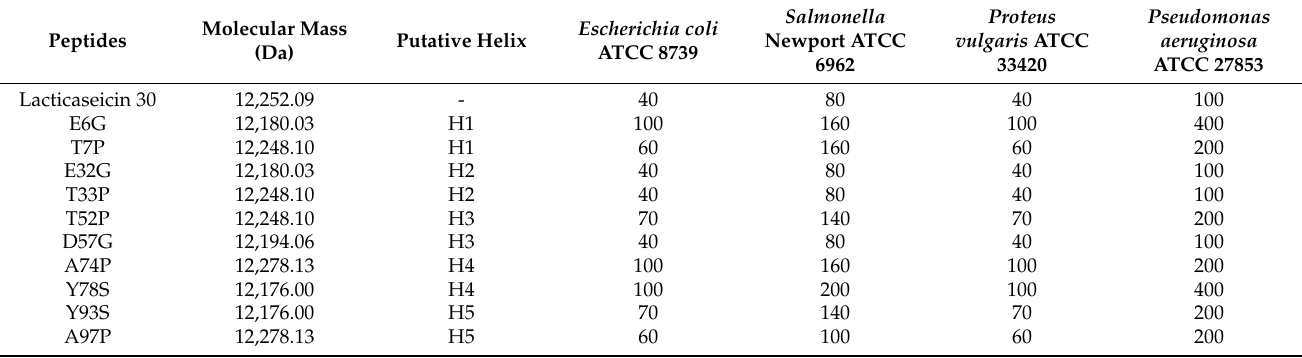
Table 2. Minimum inhibitory concentrations ( µ g/mL) of lacticaseicin 30 and its variant peptides. Molecular Mass Peptides